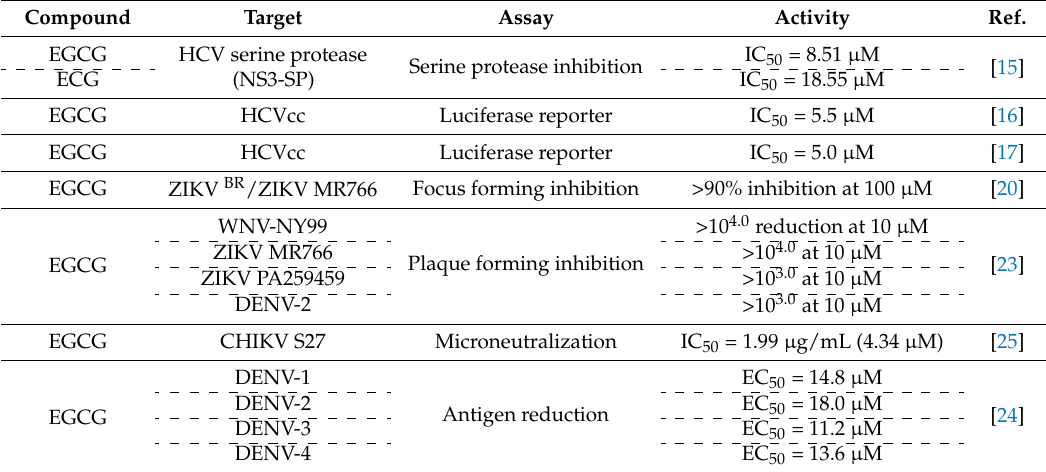
Table 2. Summary of Antiviral Activity of Catechins on Enveloped (+) ssRNA